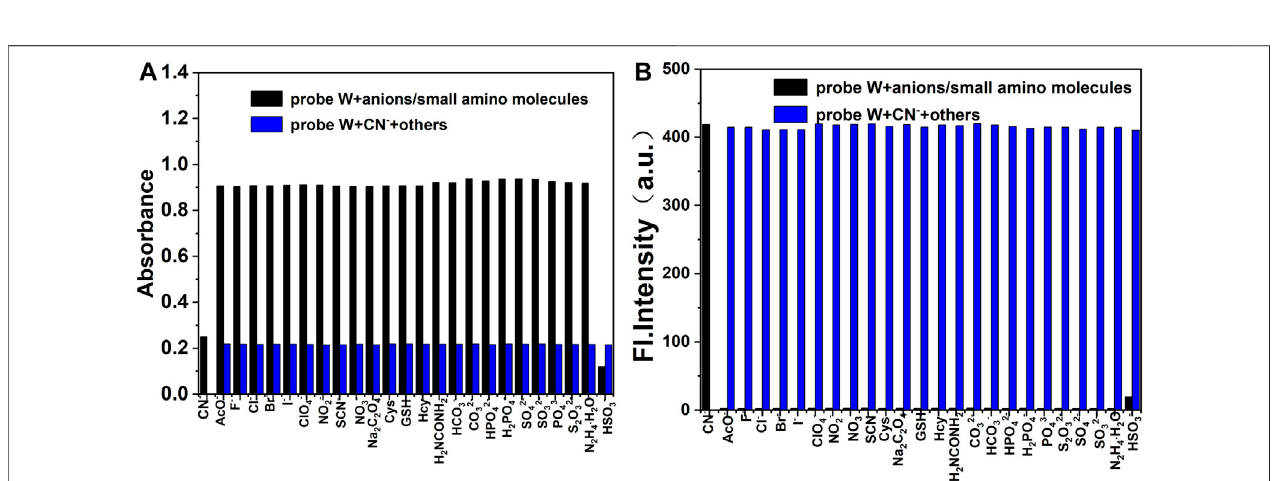
FIGURE5| Bardiagramofthecompetitiveexperimentsofvariousanionsand amino-containingsmallmolecules ontheabsorbance (A) and fl uorescenceintensity (B) of the probe/CN − complex in buffer solution ( λ ex/ λ em = 378 nm/478 nm, slit: 5/5 nm, and voltage: 500 V).